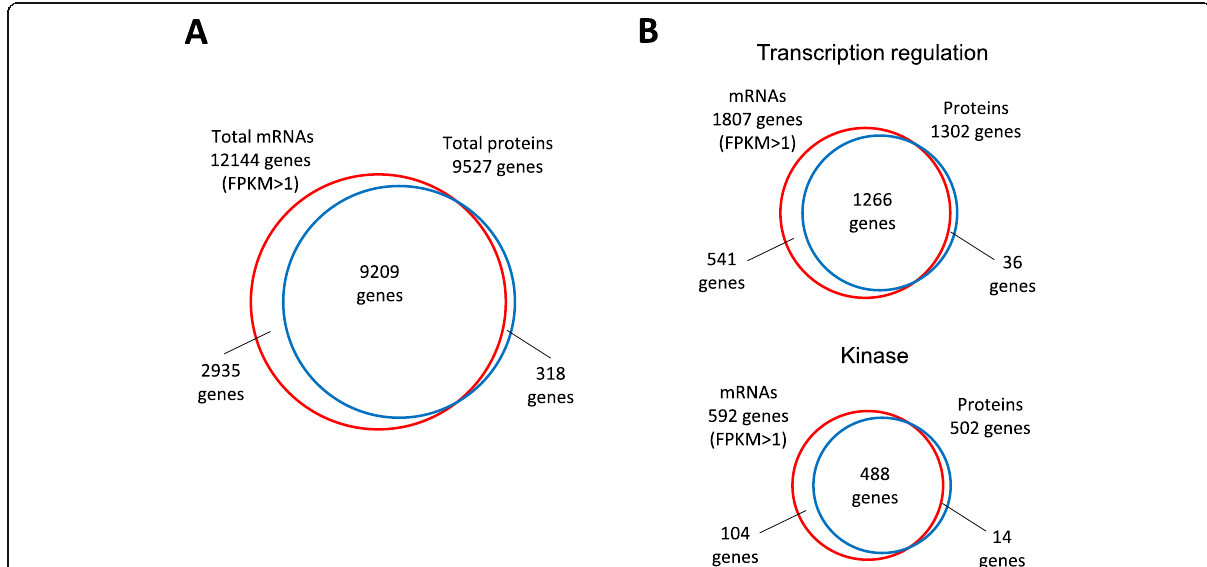
Fig. 1 In-depth protein profiling using DIA-LC-MS/MS. Venn diagrams of genes detected by profiling of mRNAs [7] and proteins in HEK293 cells. A The overall genes and B the genes categorized as “ Transcription regulation ” and “ Kinase, ” detected by omic profiling. Genes included in these two categories were extracted from Uniprot Keyword. Gene coverage of RNA profiling is close to that of protein profiling but includes some unique genes in each